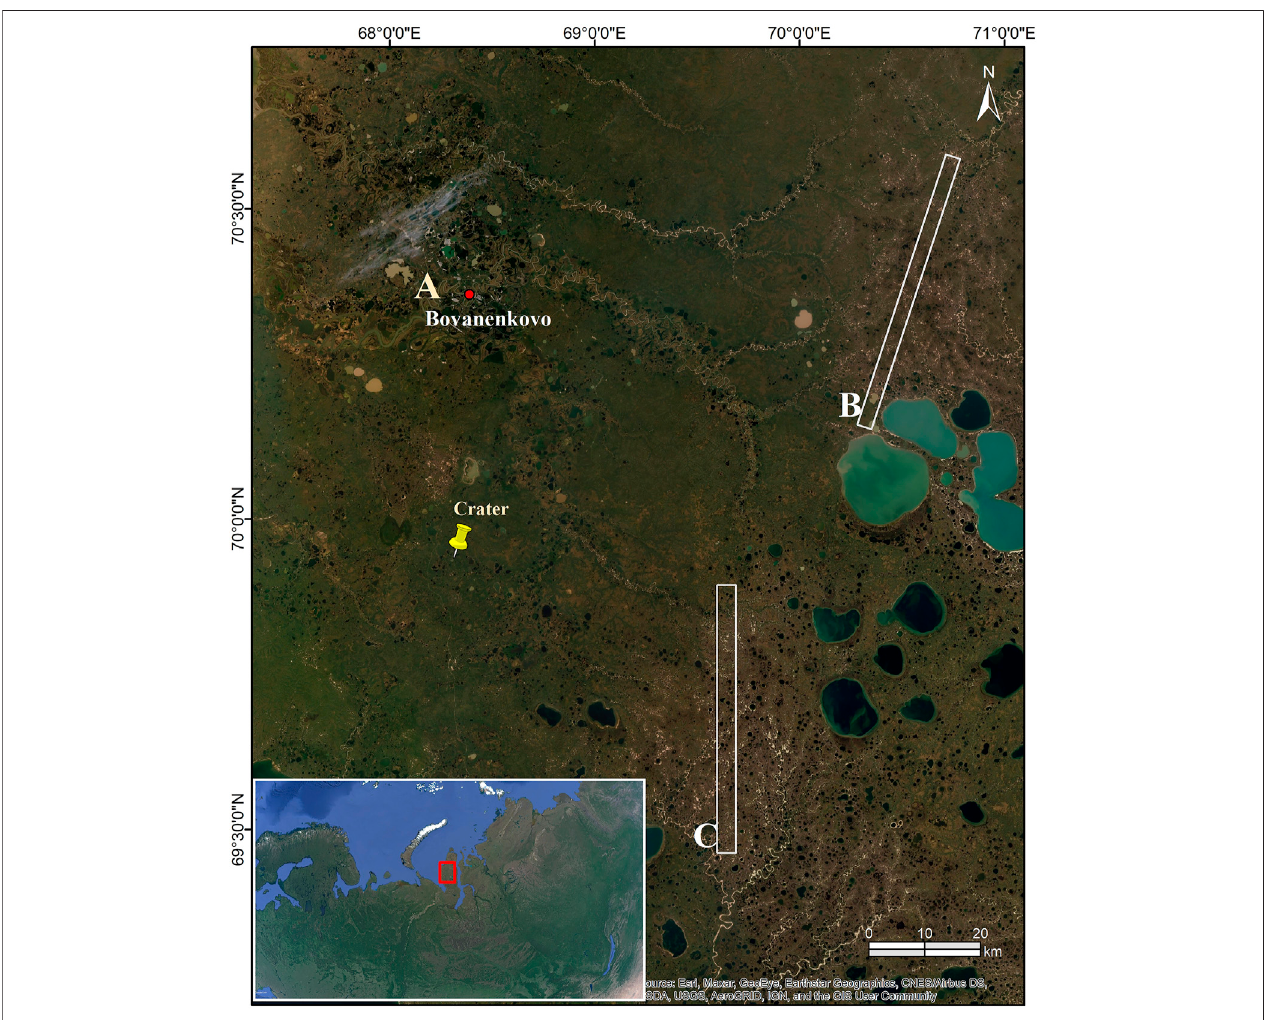
FIGURE1| StudyarealocatedintheYamalpeninsulaofthewesternSiberia.ThemapisbasedonopticalLandsat datashowinglocationoftheBovanenkovo fi eld and 2014 crater.